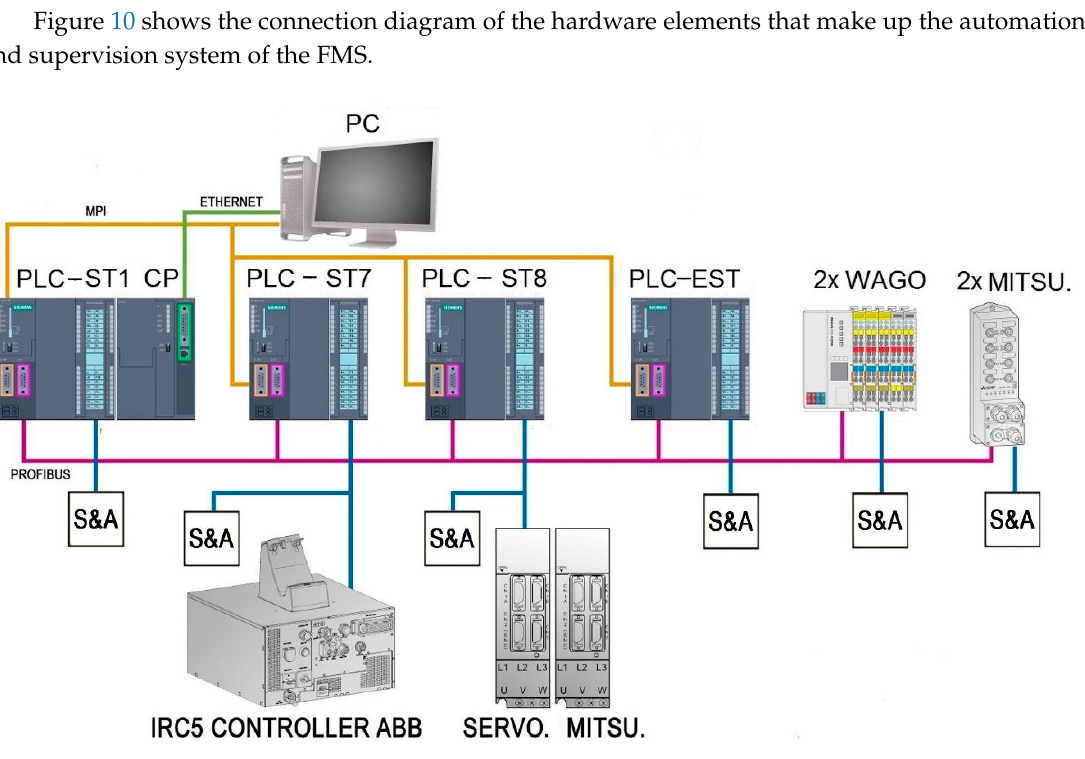
Figure 10. Block diagram of the automation and supervision system.